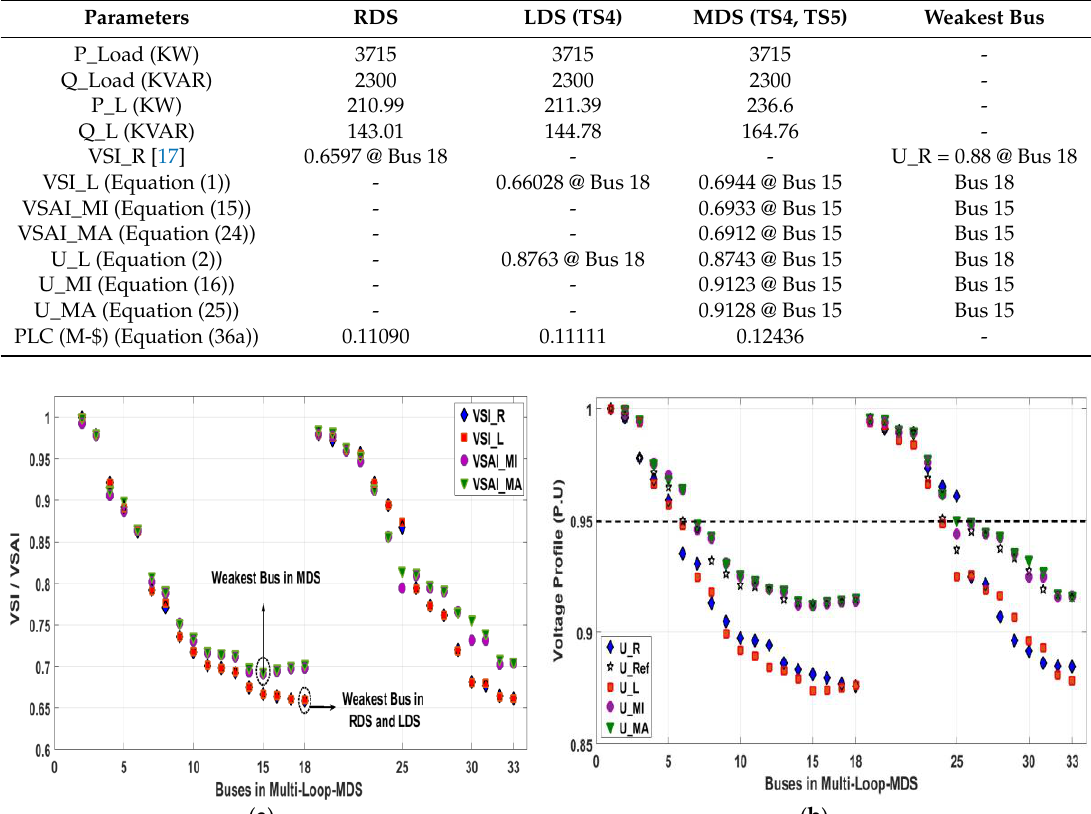
Table 1. Results of proposed approach without distributed generation (DG) units (Base Case 0a). Parameters